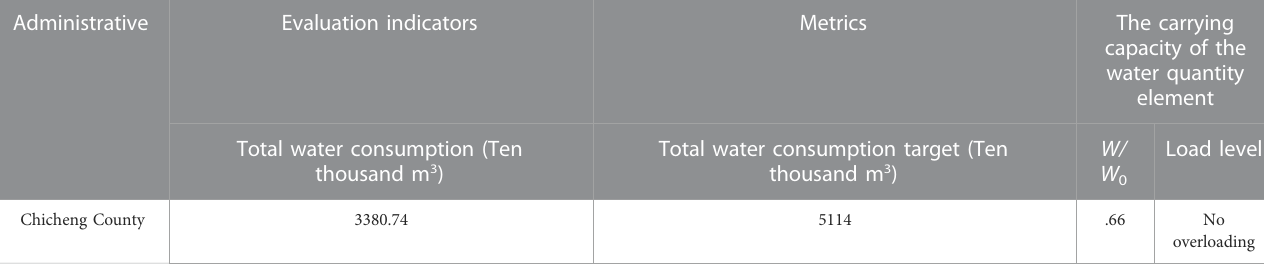
TABLE 3 Evaluation table of the total water consumption capacity of the current year (2018). Administrative